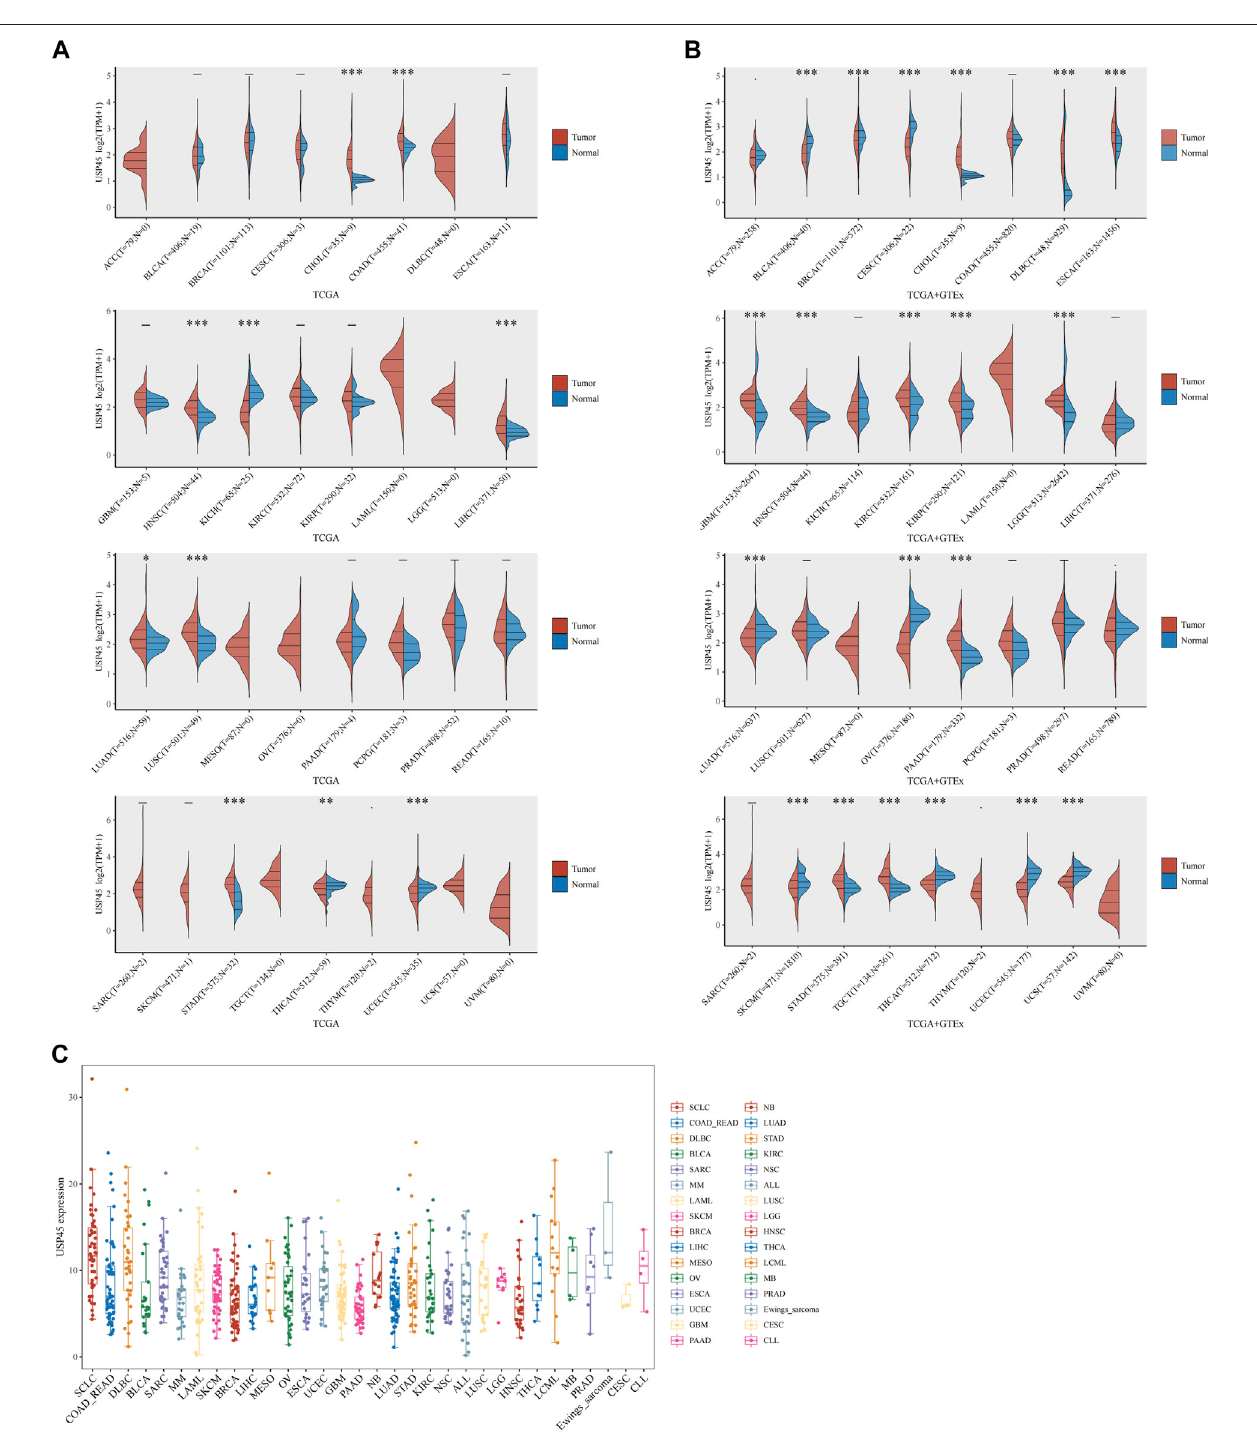
FIGURE 1 | The expression analysis for USP45 in multiple types of cancer tissues and cell lines. RNA-seq data of 33 types of tumor and normal tissues were downloaded from The Cancer Genome Atlas (TCGA) database and GTEx database. (A) The expression of USP45 in 33 types of human cancer and normal tissues was analyzed based on TCGA database. (B) The expression of USP45 in 33 types of human cancer and normal tissues was analyzed based on TCGA and GTEx database. (C) The expression levels of USP45 in 946 types of tumor cell lines were analyzed based on the CCLE database. * p < 0.05, ** p < 0.01, *** p < 0.001. The statistical difference of two groups was compared through the Wilcox